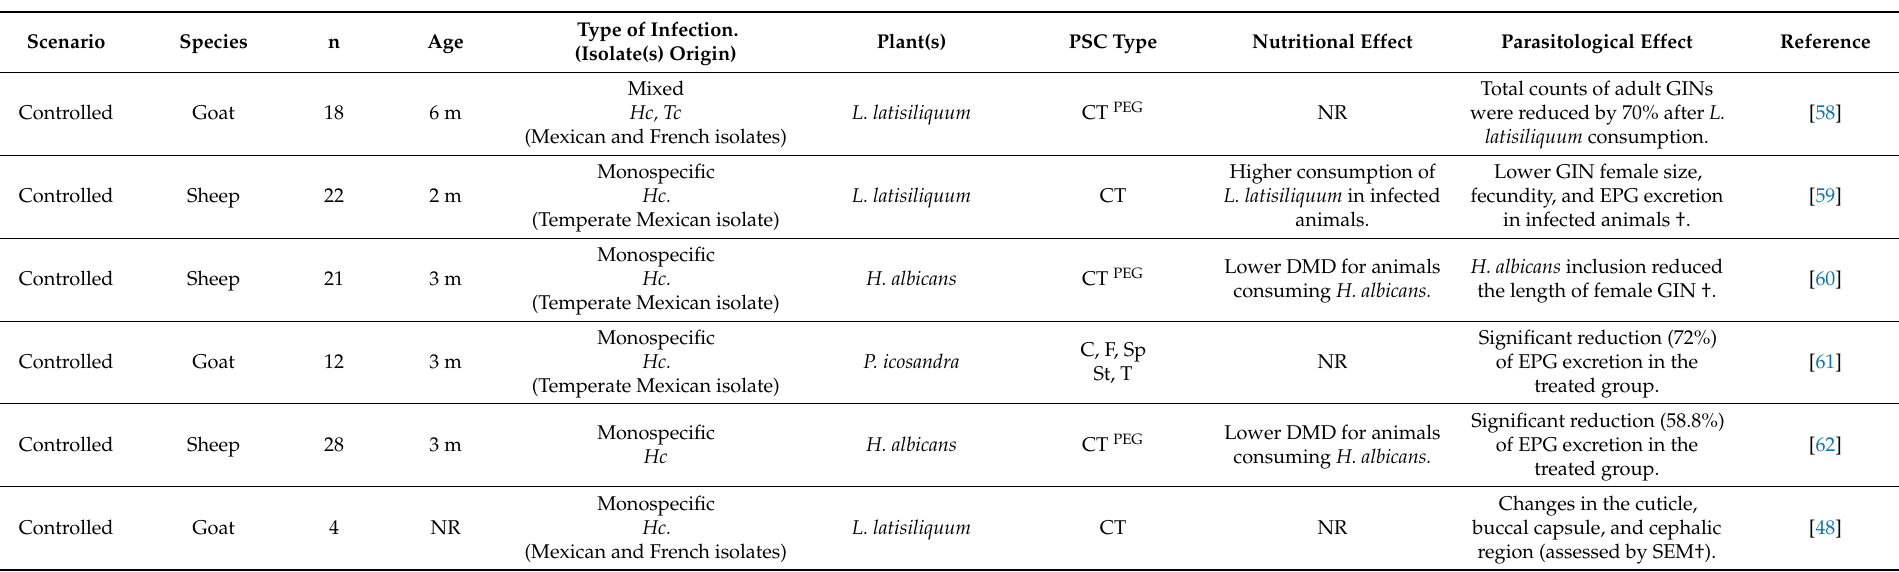
Table 2. Nutritional and parasitological effects reported for sheep or goats when consuming the leaves of different plants from the low deciduous forest in pen studies or cafeteria studies, either with natural or controlled GIN